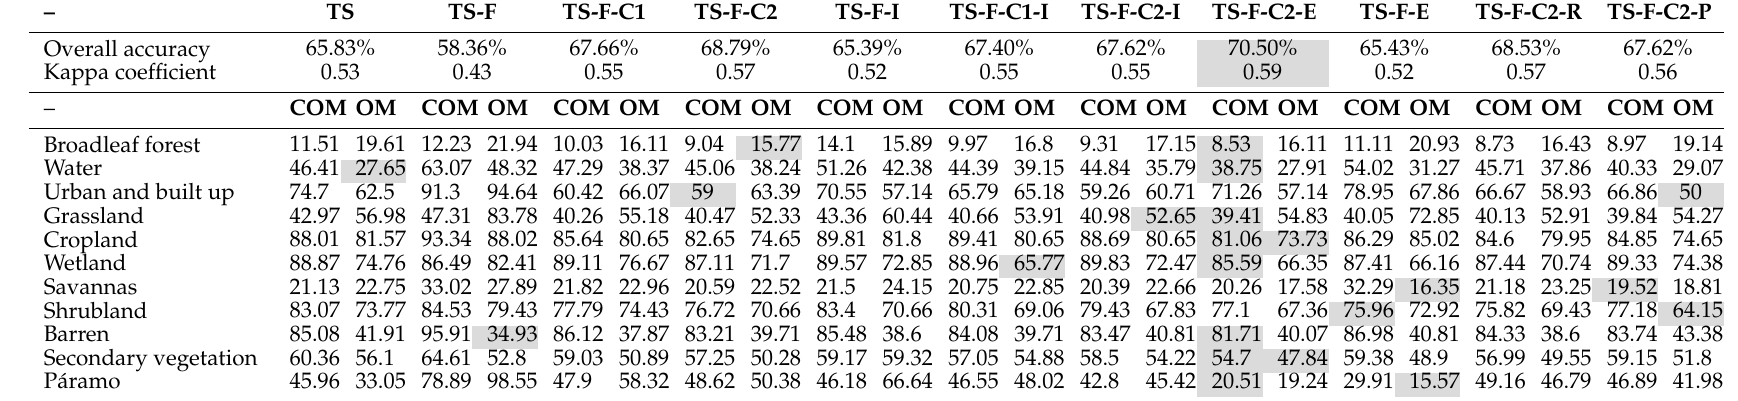
Table 6. Commission (COM) and omission (OM) errors (%) for different scenarios handling invalid pixels and adding ancillary variables. TS: time series, F: filtering for low quality observations, Cx: compositing with (cid:8) x years, I: linear temporal interpolation, E: elevation, R: radar data, and P: precipitation. Grey cells mark best